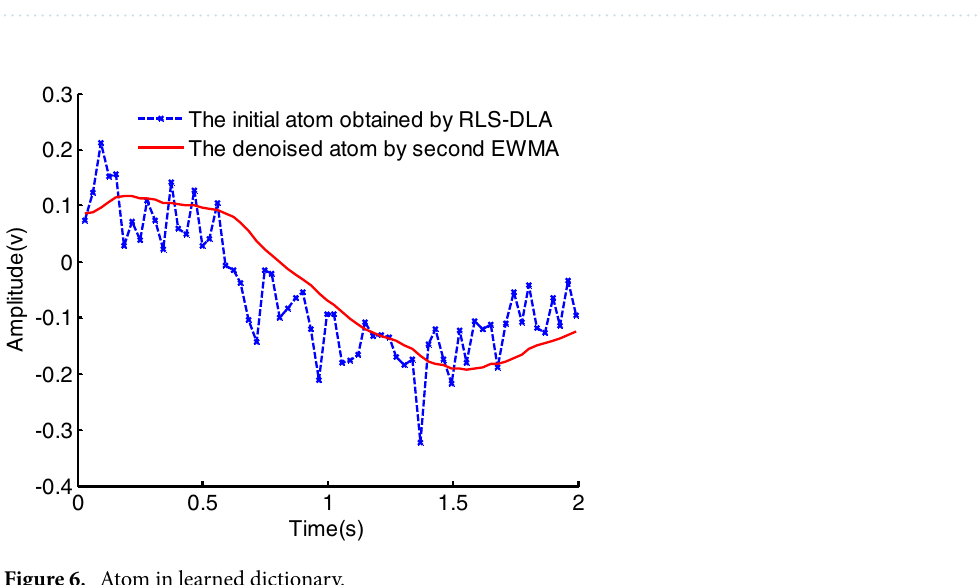
Figure 5. Curve of one atom in the dictionary learned by RLS-DLA.